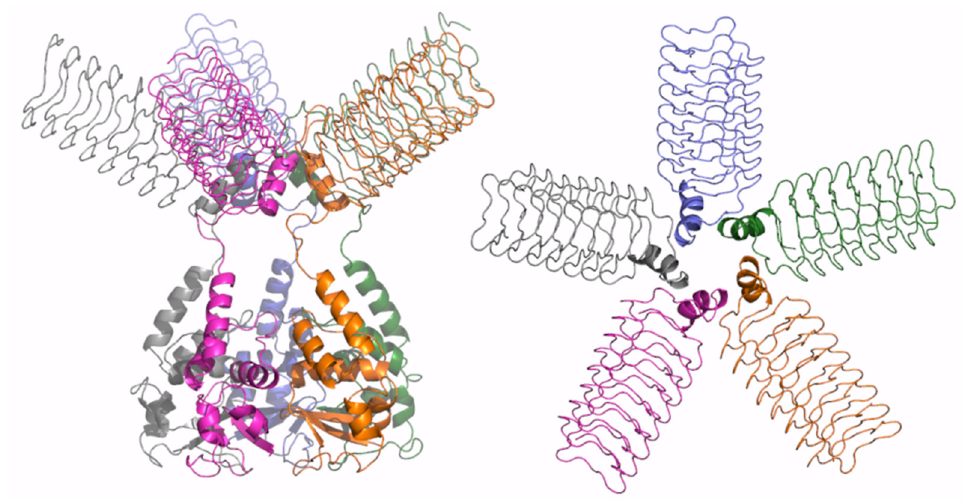
Figure 7. Schematic representation of AF full-length structure of KCTD9. The structural model was obtained by combining the AF predictions of the protein with a reduced CTD domain (residues 89–282) and of the whole CTD domain (residues 199–380). Two views are shown (on the left, the full-length pentameric assembly; on the right, the CTD domains only); the model is colored by chain.